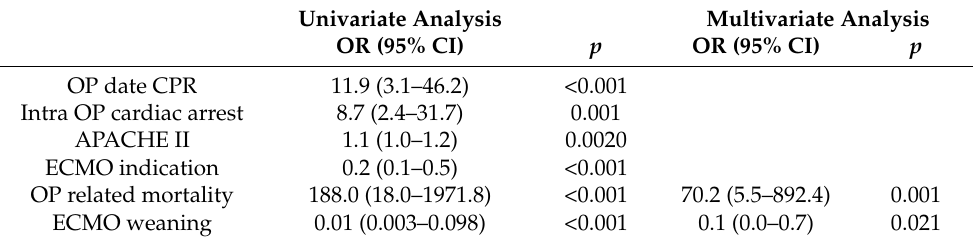
Table 3. Cox regression analysis for factors associated with 30